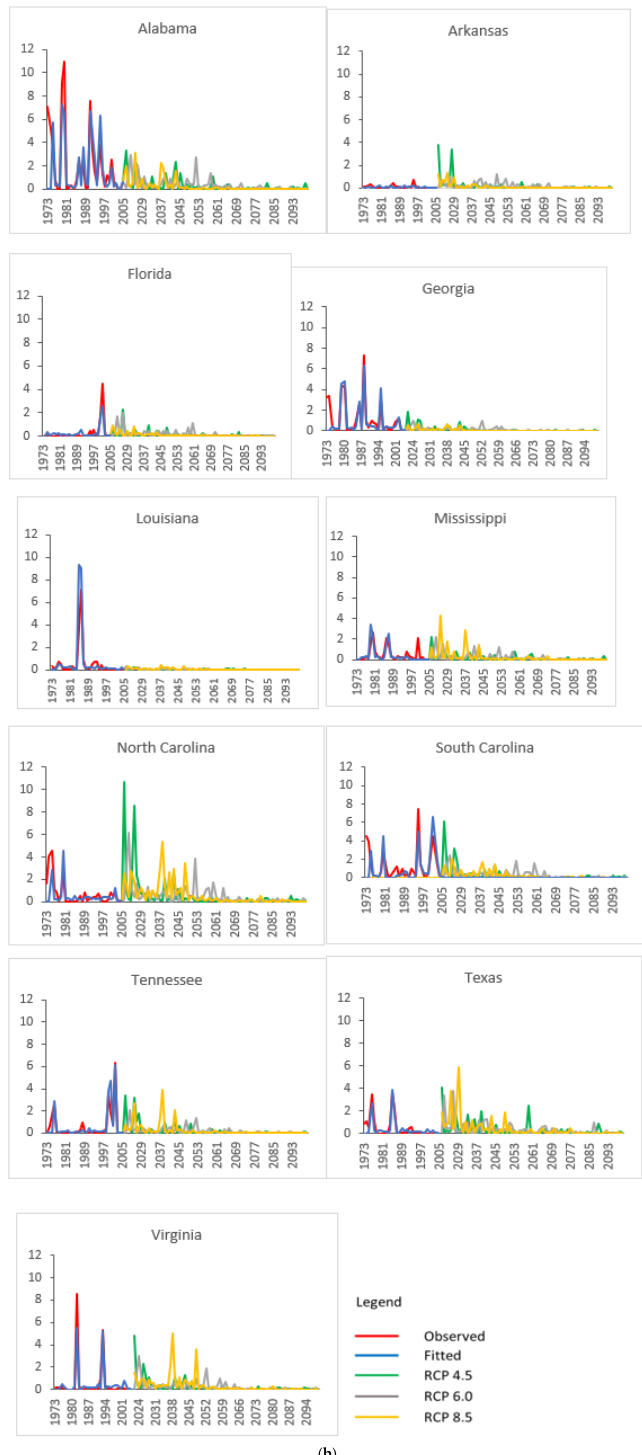
Figure 1. Historical and projected southern pine beetle (SPB) outbreak patterns in the Southern United States. ( a ) The projected SPB infestations based on the future climates projected by the HadGEM2-ES global climate model under three Representative Concentration Pathways (RCP) sce- narios (RCP 4.5, 6.0, and 8.5); and ( b ) the projected SPB infestations based on the future climates projected by GFDL-CM3 under the same three RCP scenarios. The SPB risk (the vertical axis) is measured in ‰ of the total pine growing stock volume killed by the SPB, and the horizontal axis is labeled with calendar years. 4. Discussion We found that SPB infestations would become more frequent but with smaller am- plitudes under climate change, which is counterintuitive and enriches the existing body of knowledge. There could be multiple reasons behind this, and it is unlikely to fully un- derstand all of them without more comprehensive knowledge about biotic and abiotic drivers and mechanisms of SPB cyclical infestations. Here, we attempted to shed light on possible reasons based on our modeling results and the projected future climate attributes.